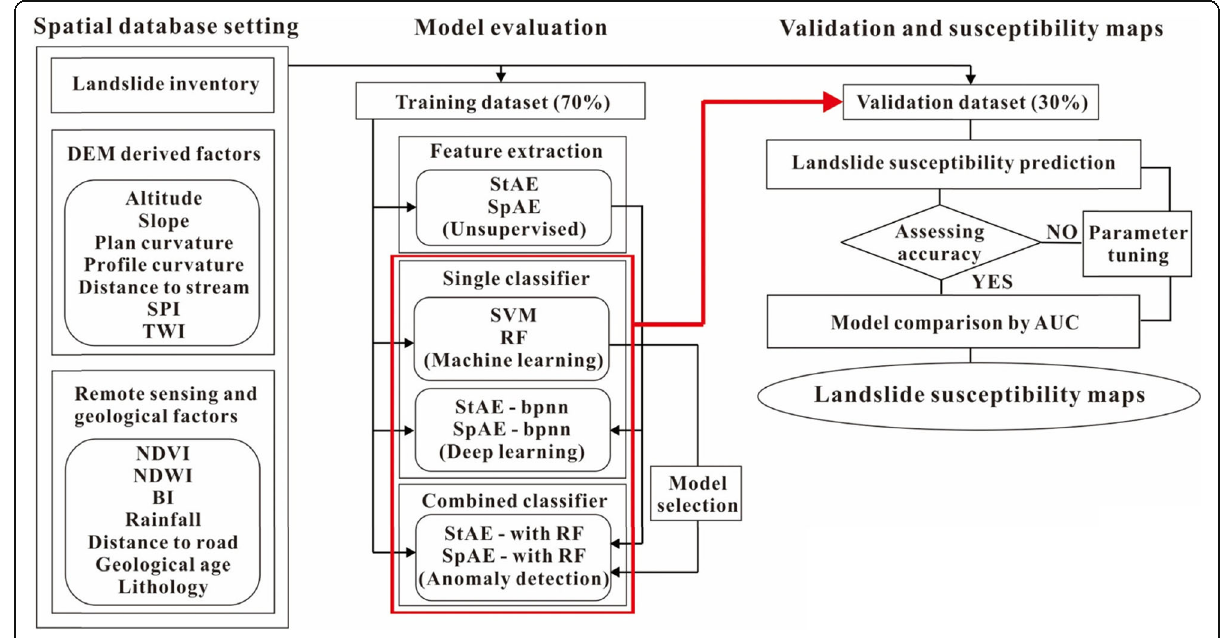
Fig. 6 Flow chart of the research